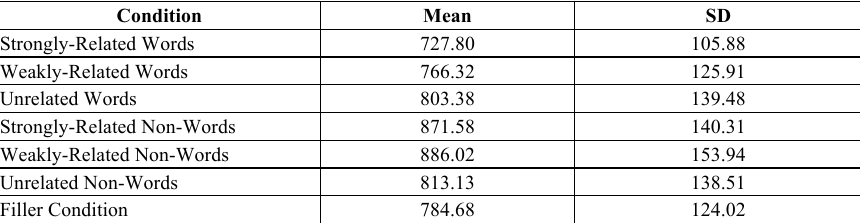
Table 1. Summary of Mean Reaction Time and Standard Deviations (in milliseconds) for